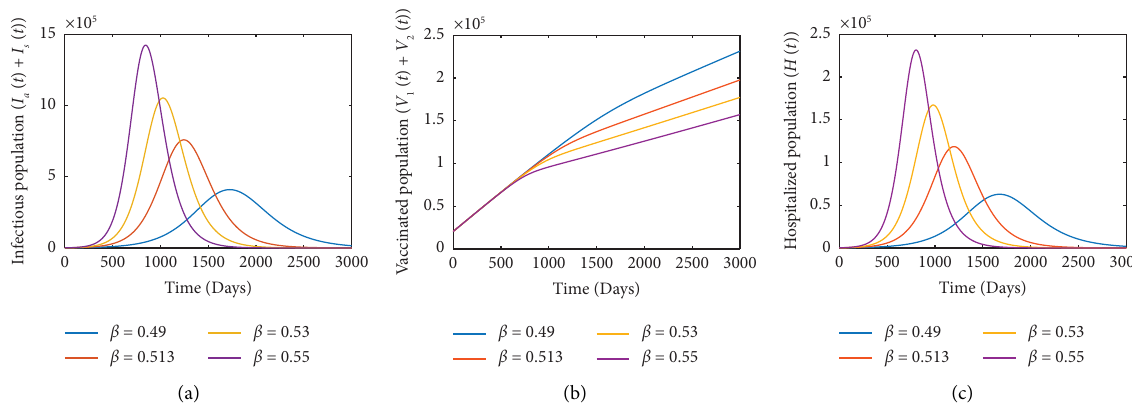
Figure 7: Te efect of transmission rate β . (a) Infectious population I hospitalized individuals. Other parameter values are given in Table 2.